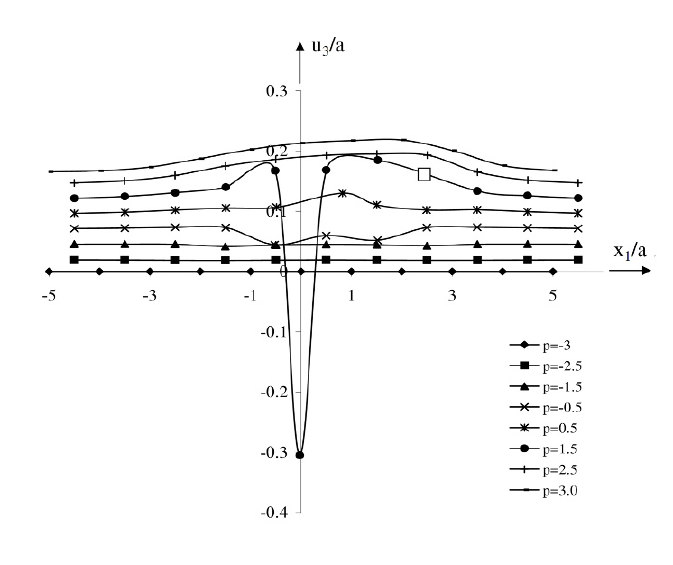
the nearest neighbors of the vacancy and those of the Al dopant, for the case L = 2 a . The positions of the nearest neighbors of the vacancy are measured with respect to the initial vacant site, while the distances from the dopant are measured with respect to its equilibrium position. The dopant is depicted with dark solid sphere and the boundaries of the (100) plane containing the vacant site is shown by dashed lines. For both cases L = 2 a and